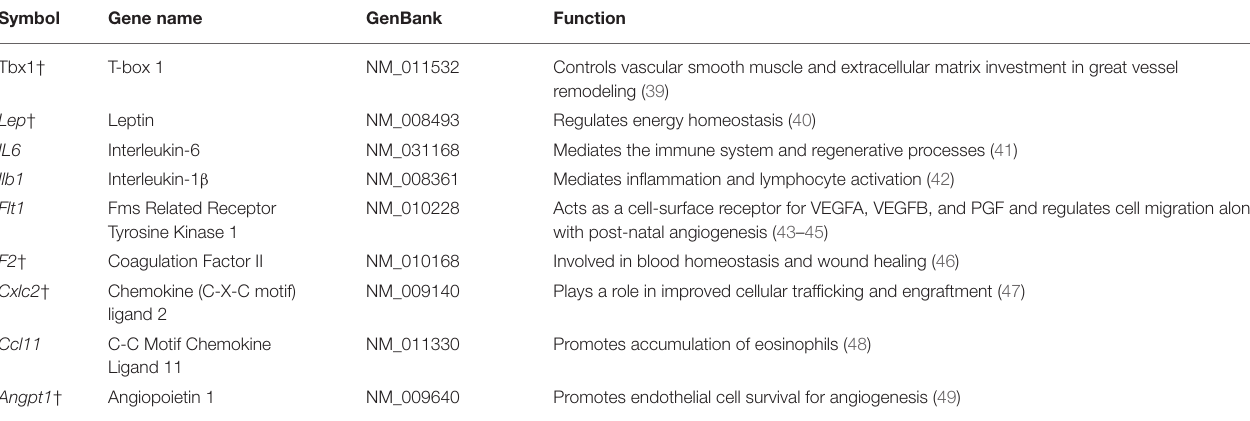
TABLE 1 | Genes upregulated in E-selectin supercharged mesenchymal stem cells (MSCs) (compared to MSC GFP ) and their previously described functions. Symbol